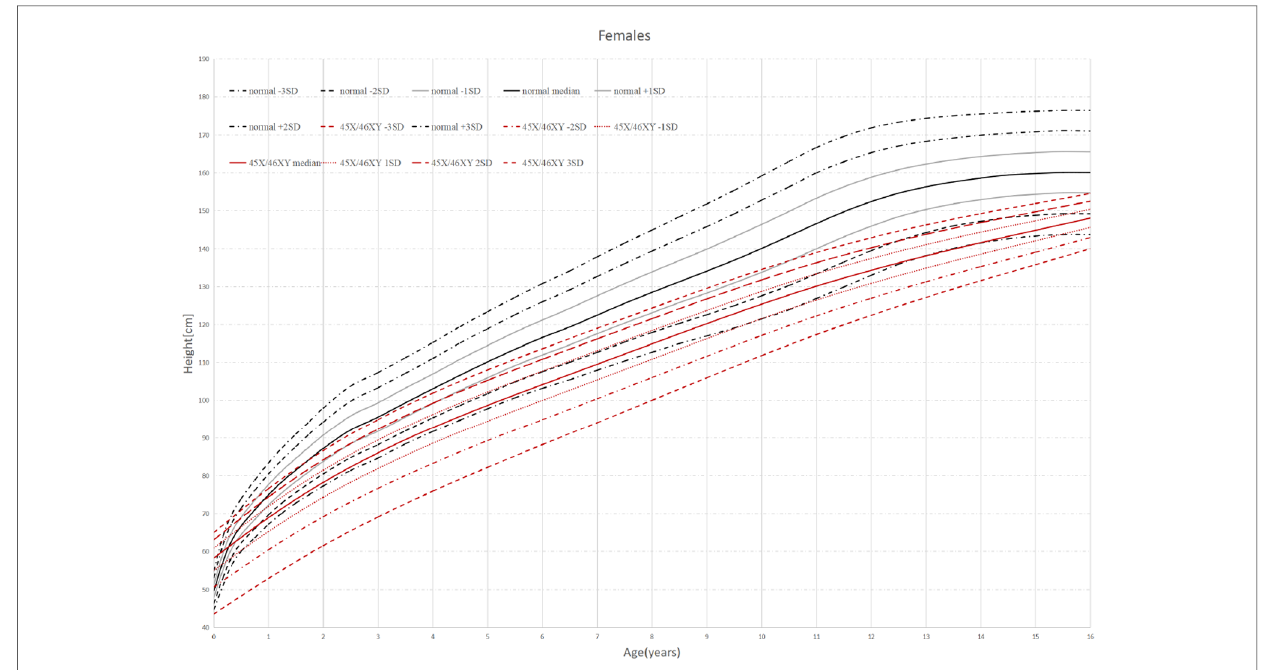
FIGURE 1 Standard deviation height curves of children with 45,X/46,XY mosaicism and normal Chinese